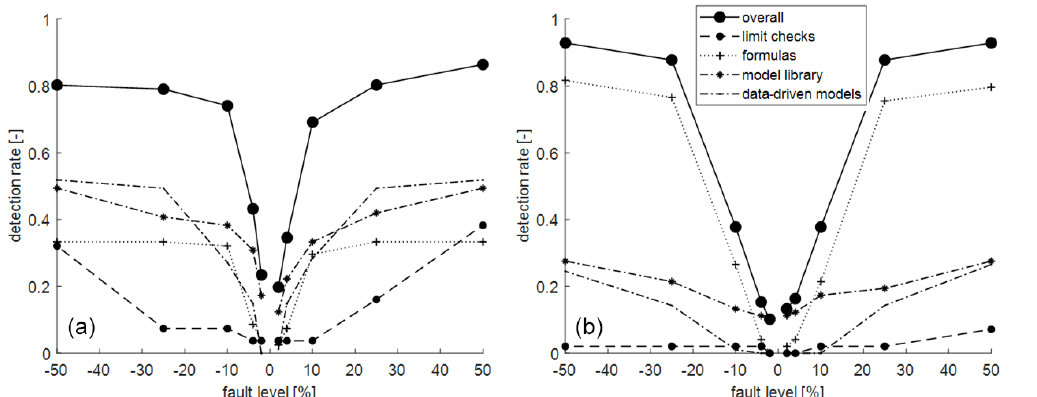
Figure 4. The detection rate ( R D ) at specific fault levels of the individual residual generation tools for the SCE (a) and MCE (b) . The detection rate at one fault level is averaged over all fault timings and